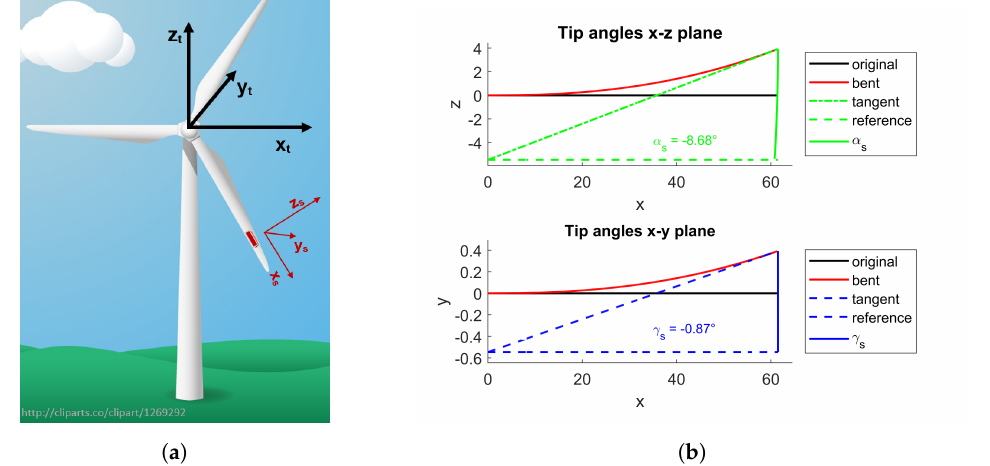
Figure 3. ( a ) Coordinate systems of the turbine and sensor and ( b ) the resulting change in orientation of the sensor due to blade bending, adapted from [17].